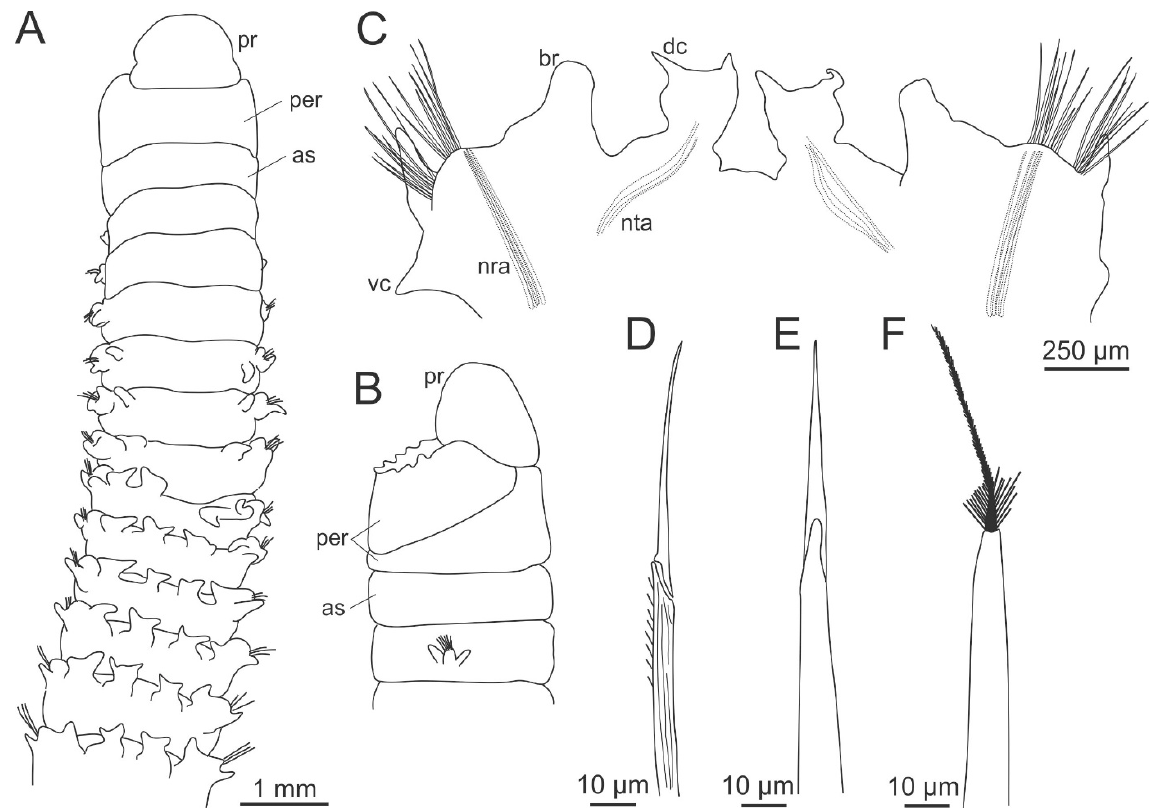
Figure 6. Morphology of Hartmaniellidae. ( A ) Hartmaniella sp., anterior end, dorsal view; ( B ) the same, anterior end, lateral view; ( C ) the same, parapodia from midbody region shifted dorsally; ( D ) Hartmaniella tulearensis (Amoureux, 1978), composite spiniger; ( E ) the same, acicular spine; ( F ) the same, acicula. as–achaetous segment, br–branchia, dc–dorsal cirrus, nra–neuropodal aciculae, nta–notopodial aciculae, per–peristomium, pr–prostomium, vc–ventral cirrus. ( B ), ( D – F ) modified from Carrera-Parra [232].